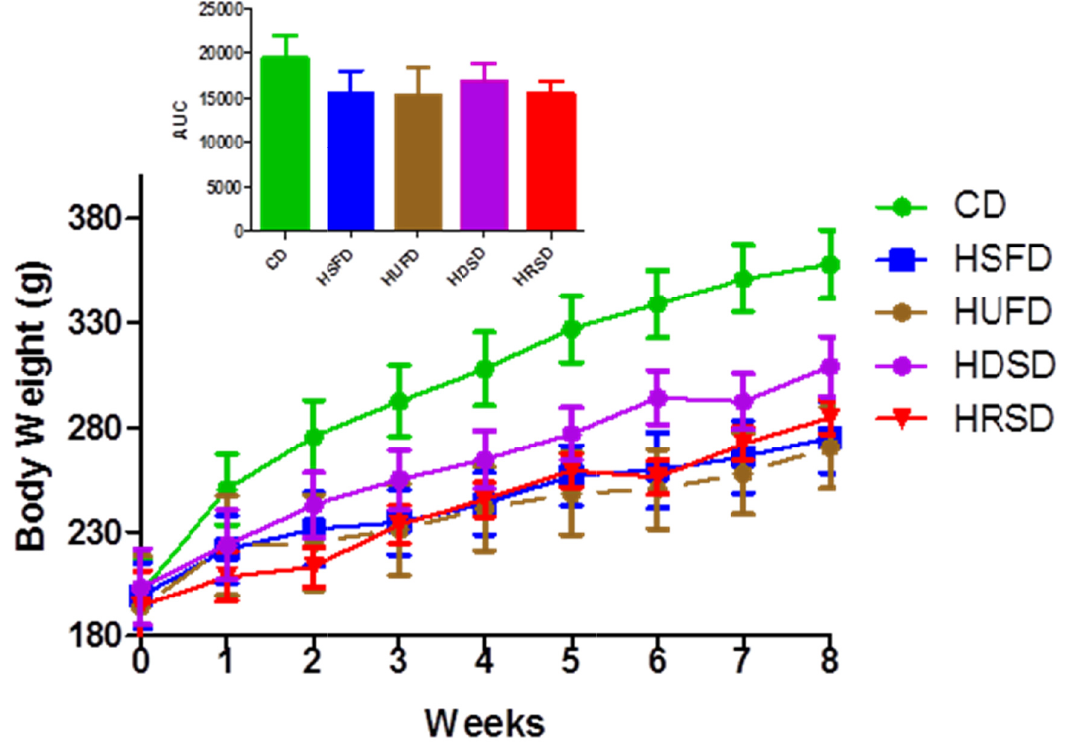
during Body wei Calories ( Values are mean ± S (small l high-un Bonferr